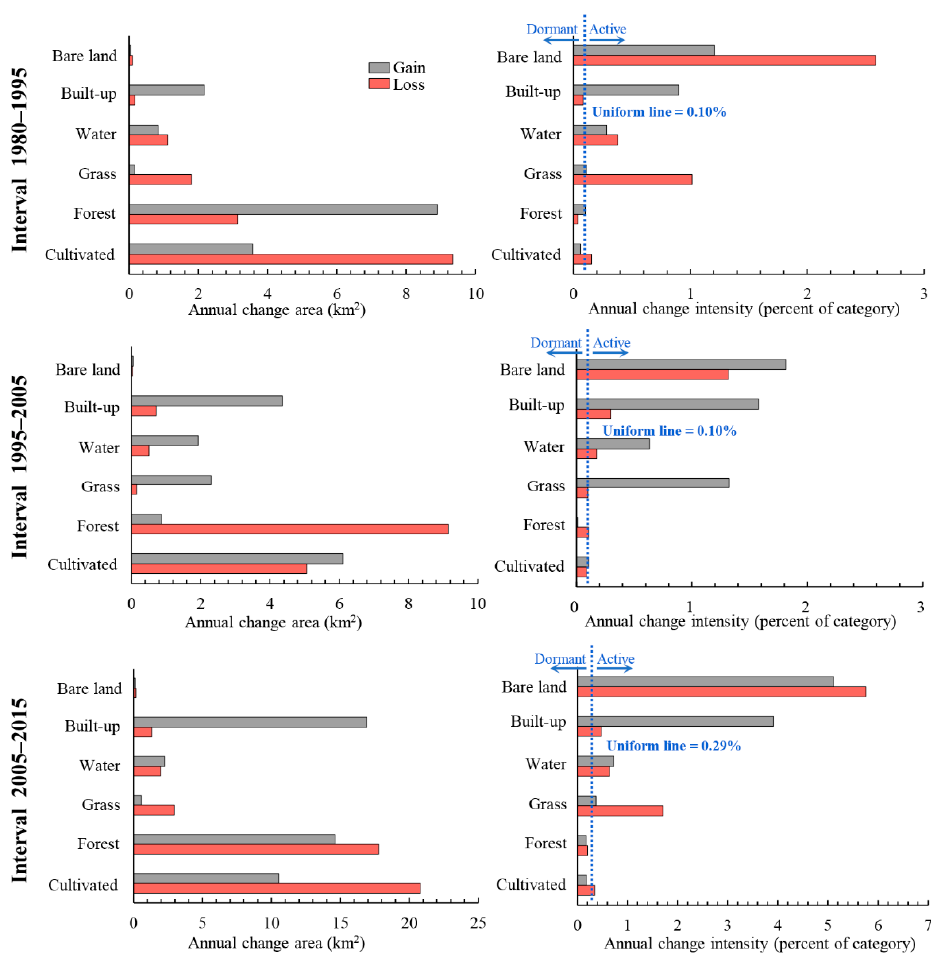
Figure 6. Annual size and intensity by category at three intervals.